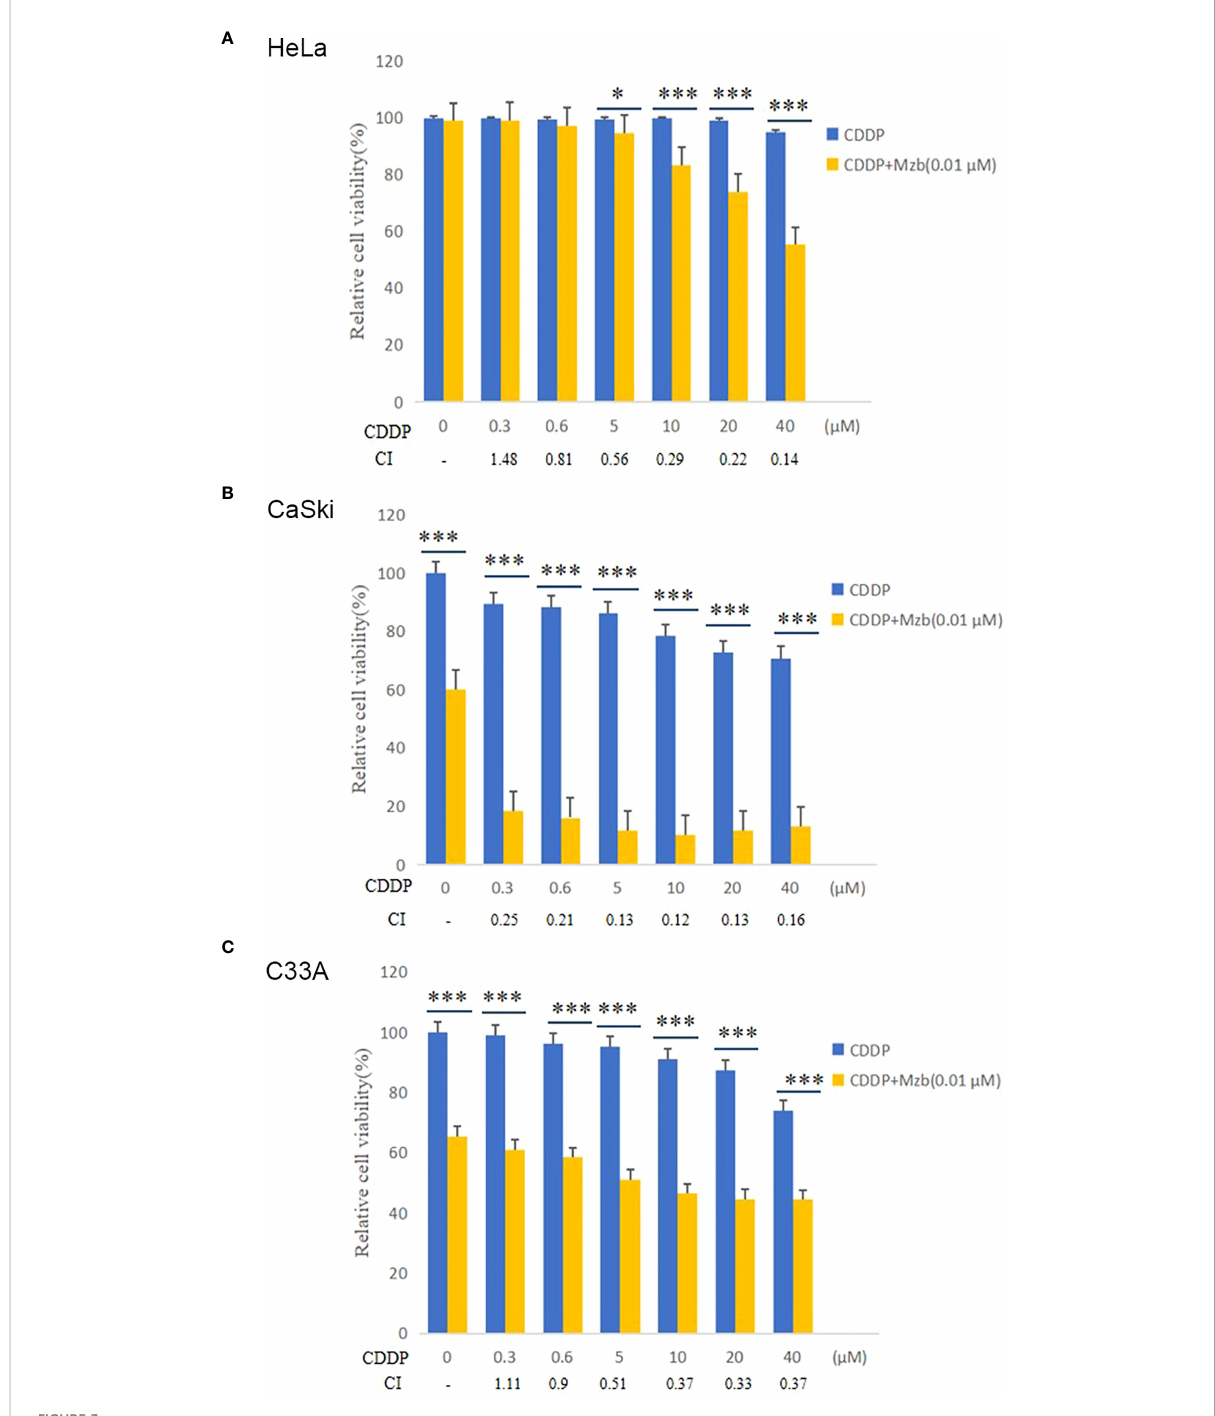
FIGURE 3 Marizomib enhances the cytotoxic effect of CDDP on cervical cancer cells. (A – C) The cervical cancer cell lines HeLa, CaSki and C33A were treated with CDDP at the indicated concentrations with or without 0.01 m M marizomib for 72 h. Cell viability was then measured by CCK-8 assays. CI values were determined using CompuSyn software. The data were presented as the mean ± SD. *P<0.05, ***P ≤ 0.001, by t